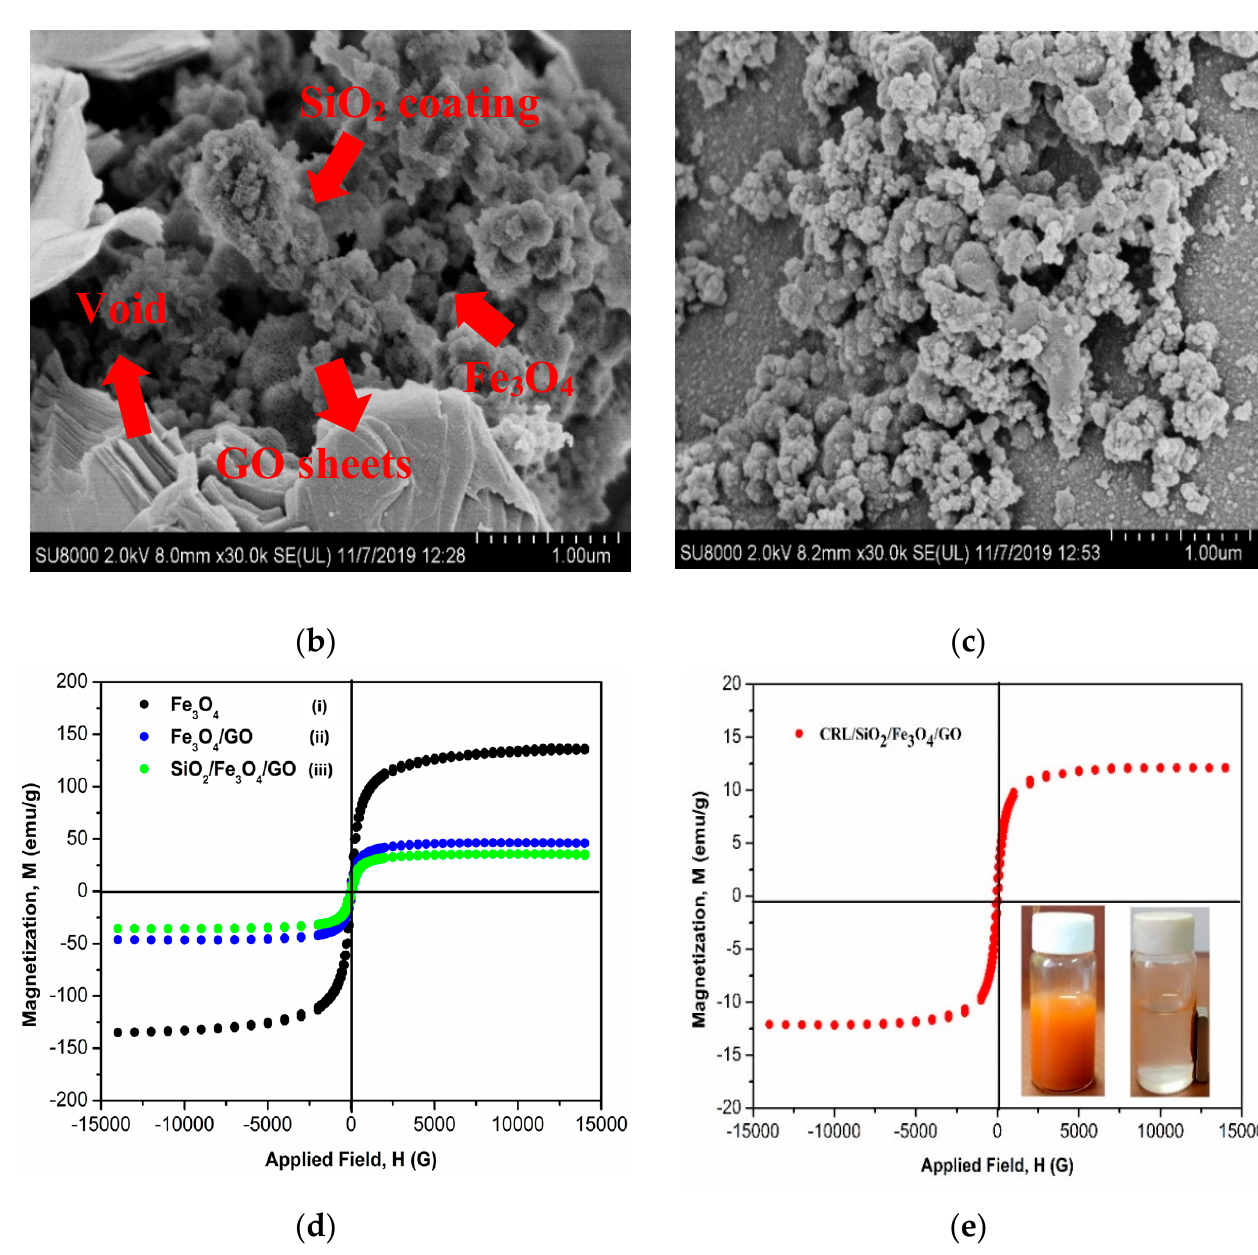
Figure 2. ( a ) N 2 adsorption–desorption isothermal curve and insert pore distribution of GL-A-SiO 2 /Fe 3 O 4 /GO support; ( b , c ) FESEM micrographs of SiO 2 /Fe 3 O 4 /GO and CRL/SiO 2 /Fe 3 O 4 /GO (30,000 × magnification); ( c , d ) Magnetization curves depicting the magnetic properties for (i) Fe 3 O 4 , (ii) Fe 3 O 4 /GO, (iii) SiO 2 /Fe 3 O 4 /GO, and ( e ) CRL/SiO 2 /Fe 3 O 4 /GO biocatalyst.